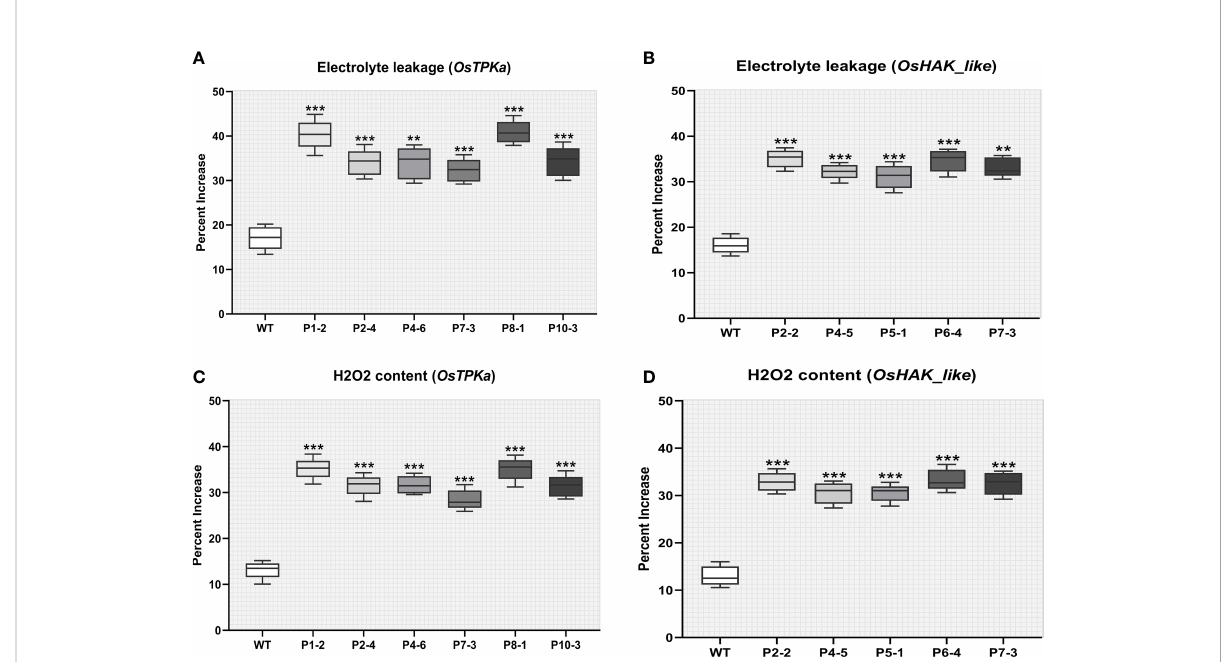
FIGURE 7 Effect of salt stress on phenotypical characteristics of transgenic plants. (A – D) Percentage increase in electrolyte leakage and H 2 O 2 content; In all the parameters wild type Horkuch performed better compared to sgRNA inserted transgenic lines. The stars in the graph indicates signi fi cant differences (***P < 0.001, **P < 0.01, Ordinary one way ANOVA